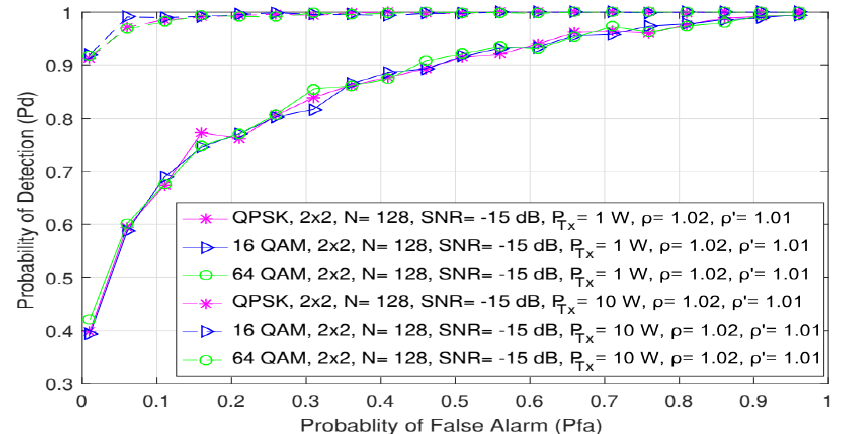
Figure 7. The ROC curves presenting ED performance for MIMO system impacted with different PU Tx powers and modulation schemes.